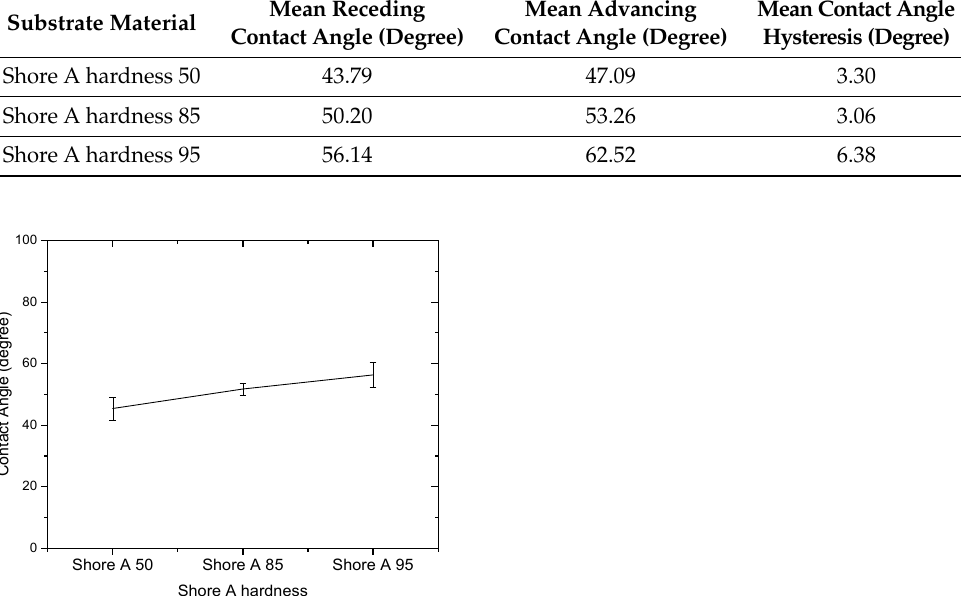
Table 1. Contact angle results of substrates without Parylene C coating. Substrate Material